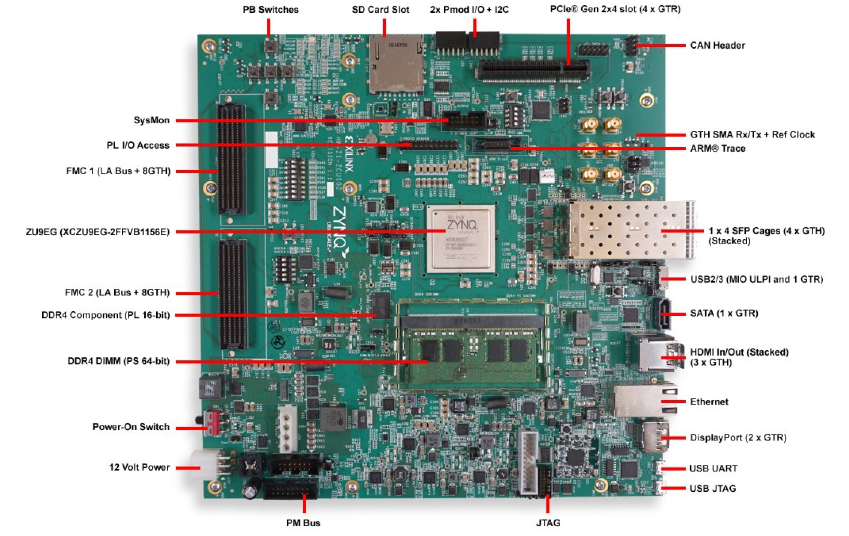
Figure 7. ZCU102 evaluation board